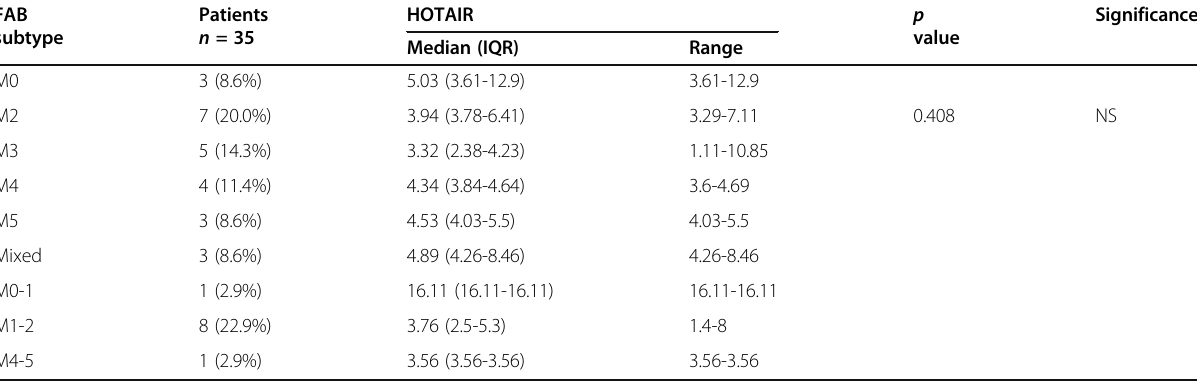
Table 4 Relation of HOTAIR expression and FAB subtypes of AML FAB subtype